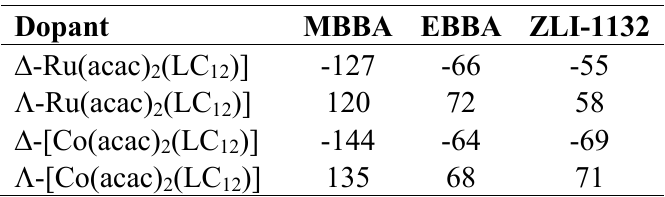
Table 3. Values for HTP ( β (60 °C) and ZLI-1132 (35 °C). This table is modified from one in reference